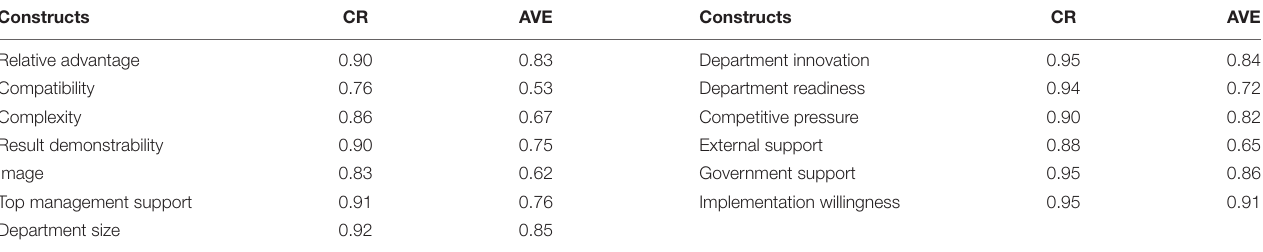
TABLE 5 | Composite reliability and AVE (dependent variable: implementation willingness).